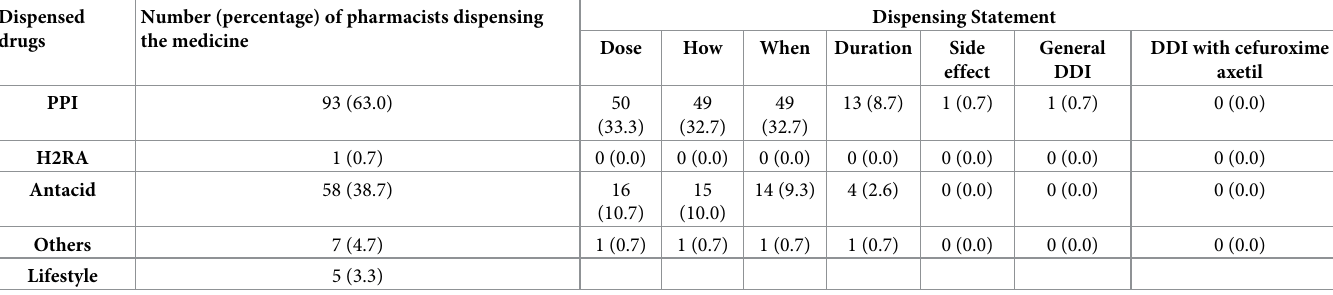
Table 4. Dispensing practice across community pharmacists (n =